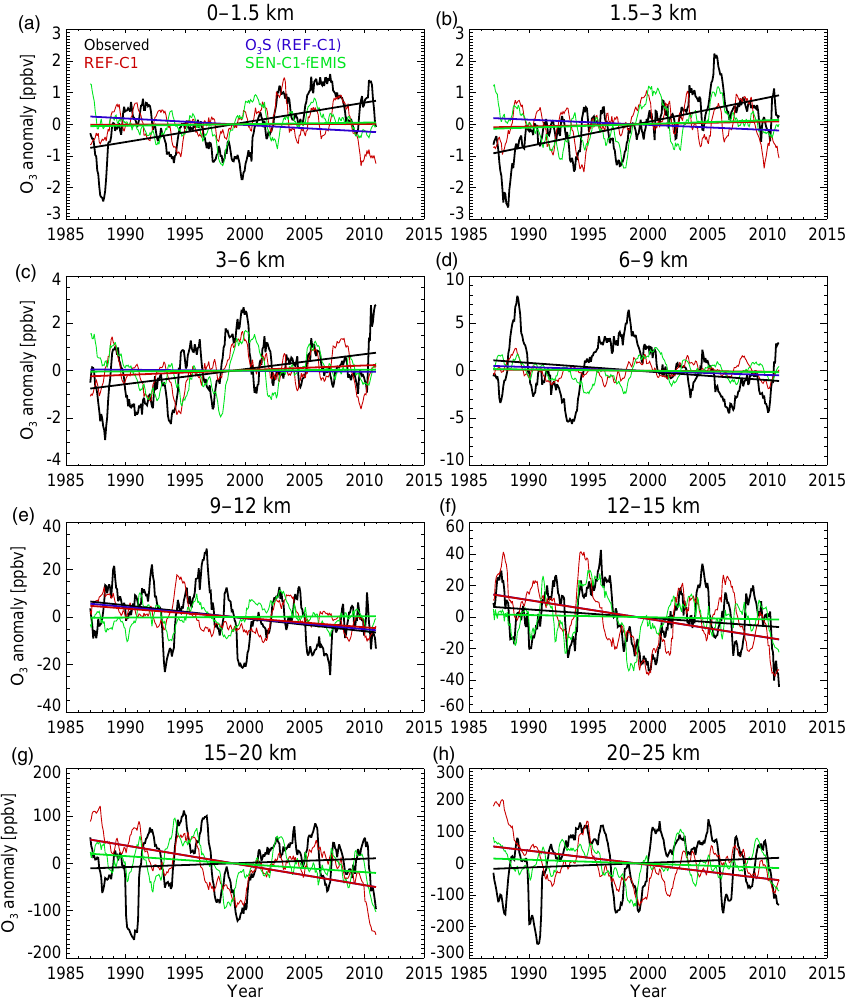
Figure 7. Observed (black) and modelled O 3 anomalies and corresponding linear trends, from REF-C1 (red) and SEN-C1-fEMIS (green), respectively, at Lauder (1987–2010), and the linear trend in O 3 S (blue line) from REF-C1. Anomalies shown are smoothed with a 13-monthly filter for the purpose of display. Table 5. Attributions of modelled trends ( ± 1 standard deviation) due to changes in non-methane O 3 precursors (NMOPs), CH 4 , GHGs, and ODSs over the period 1987–2010 and 1987–2014, respectively, calculated as trends in absolute differences between O 3 anomalies from the sensitivity simulations and O 3 anomalies from the REF-C1 and REF-C2 simulation, respectively. Units are ppbvyear − 1